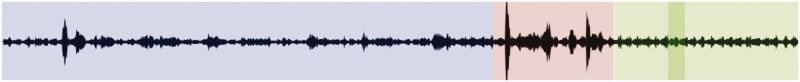
Annotated waveform generated using the Regions plugin for wavesurfer.js. Annotated regions are colour coded by the type of annotation (blue for voice introductions, red for extraneous noise and green for calls). From: http://bio.acousti.ca/node/11778.